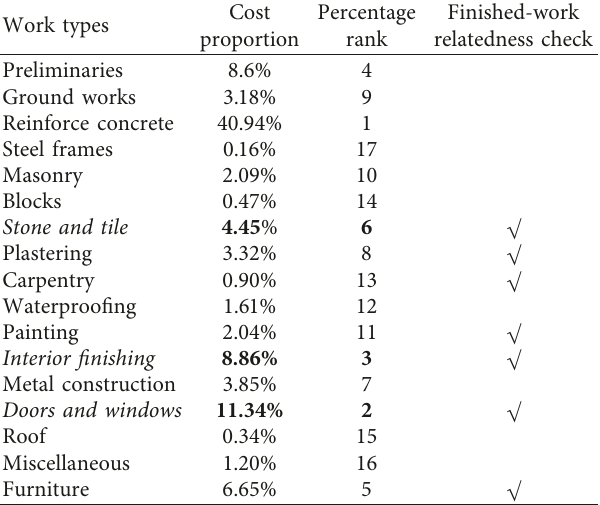
Table 1: Building cost proportion analysis and finish-work re- latedness check.